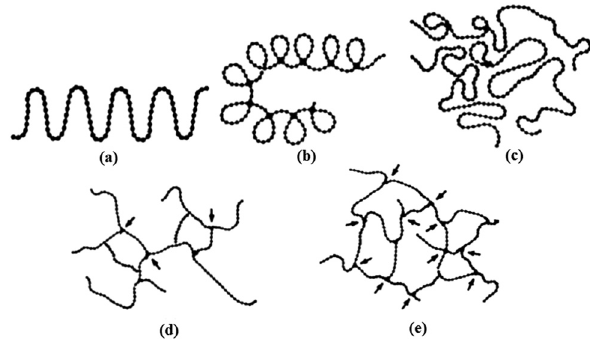
Figure 8: ( a – c ) Schemes of linear con fi guration polymers, ( d ) lightly cross - linked network polymer, and ( e ) highly cross - linked network polymer [ 42 ] .